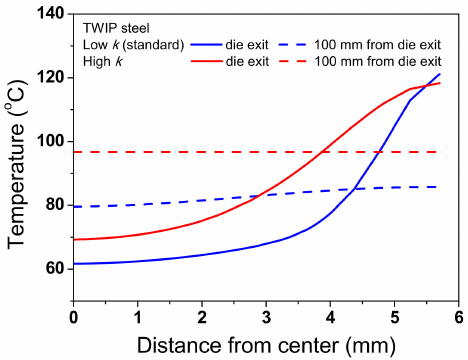
Figure 12. Comparison of temperature profiles along the radial direction of TWIP steel at die exit and 100 mm from die exit with different thermal